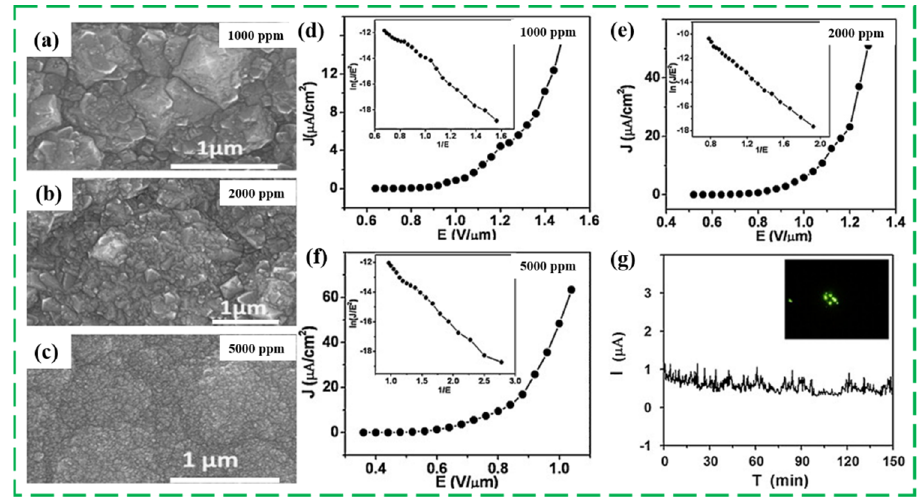
Figure 8. The SEM images ( a – c ), field emission curves ( d – f ) prepared with B concentrations of 1000 ppm, 2000 ppm, and 5000 ppm, and stability test ( g ) of B-doped ND films with B concentrations of 5000 ppm [90].